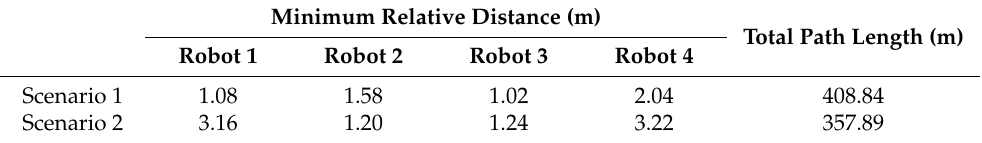
Table 4. Path optimization